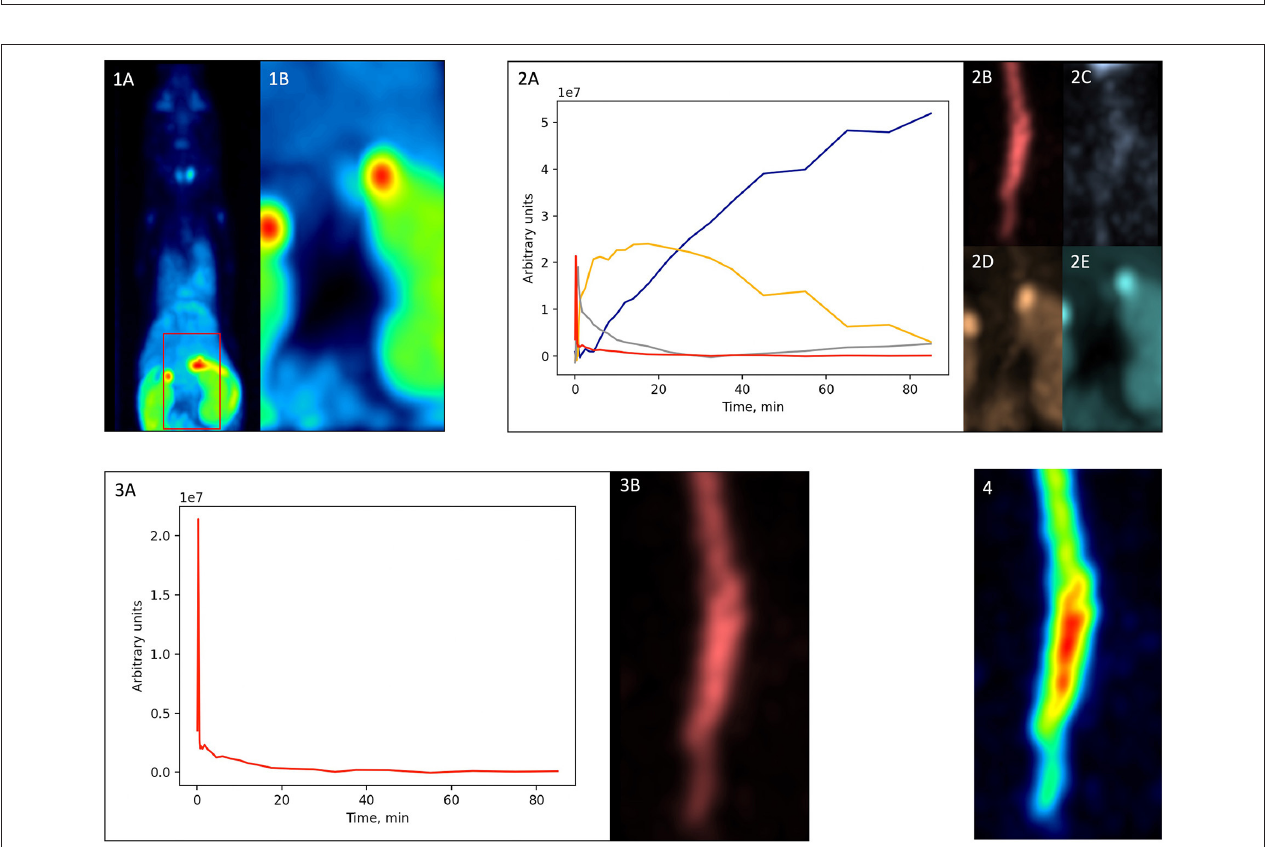
FIGURE 3 | Factor analysis-based PVE correction. (1A) —original dynamic scan (late frame is shown); (1B) —vena cava region; (2A) —factor curves; (2B–E) —factor images; (3A) —blood factor curve f 1 ( t ); (3B)— blood factor image a 1 ( i ); (4) —spill-in corrected dynamic image S * i (t) (early frame is shown).